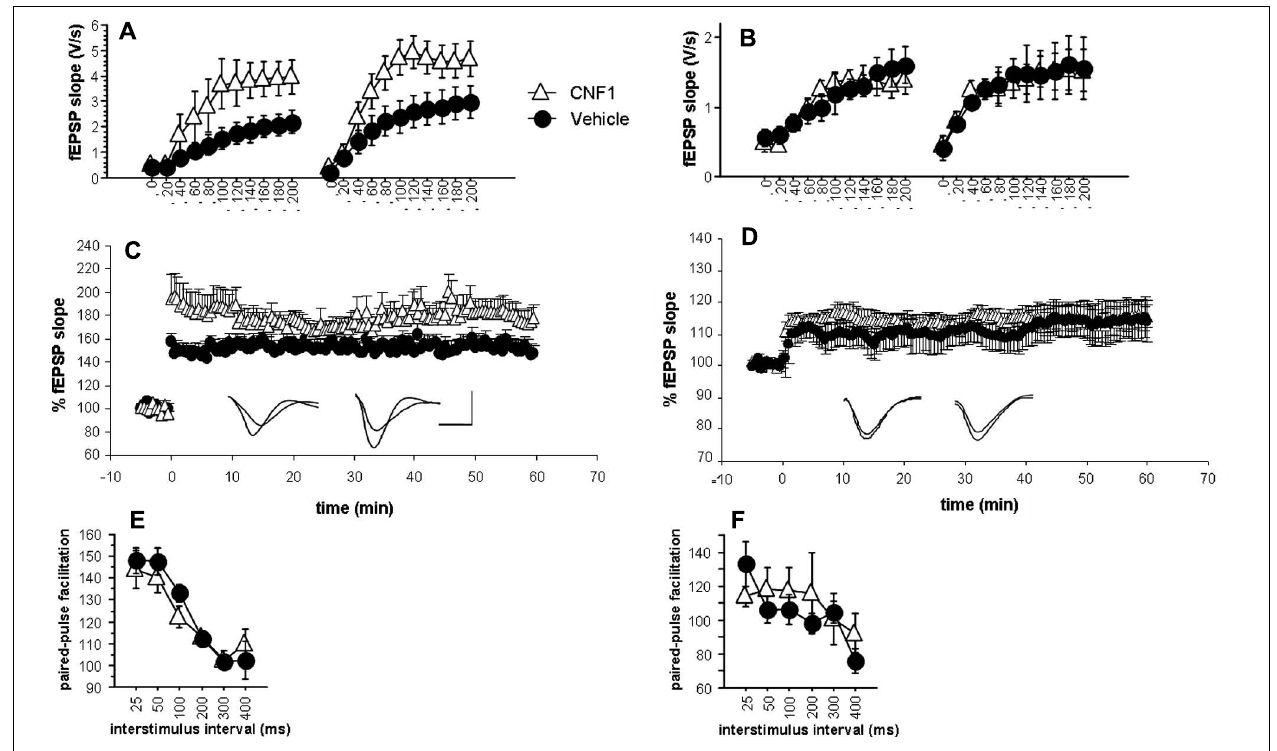
FIGURE 4 | Enhancement of glutamatergic neurotransmission and long-term potentiation in hippocampal CA1 but not inV1 visual cortex after Rho GTPase activation. Input–output curves of fEPSPs recorded 10 min before and 1 h afterinduction of long-term potentiation obtained by three consecutive theta-burst stimulation (TBS, inter-stimulation interval = 30 s; 10 trains of 4 stimuli at 100 Hz, baseline intensity; inter-train interval = 200 ms) in CNF1-treated (1.0 fmol kg − 1 i.c.v.), and control (vehicle-treated) C57BL/6J mice (control, n = 6; CNF1, n = 8); (A)